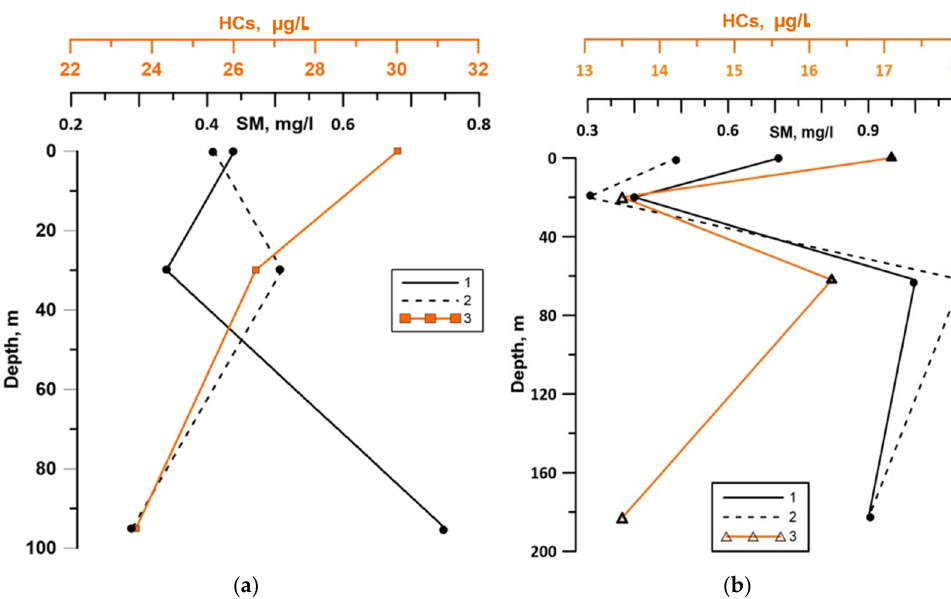
Figure 3. Variability of suspended matter concentrations with depth before (1) and after (2) removal of the trap, as well as HC (3) at station 5942 ( a ) (Kara Sea) and 5946 ( b ) (shelf slope of the Laptev Sea). The SPM concentration increased from the surface to the near-bottom horizon at most stations, with a maximum of 36 times at station 5943 (Figure 4) (from 0.6 to 21.8 mg/L), which is affected by the influx of the Ob River. In the Vilkitsky Strait, the concentration of suspended matter rose up to 32 times (from 0.1 to 3.2